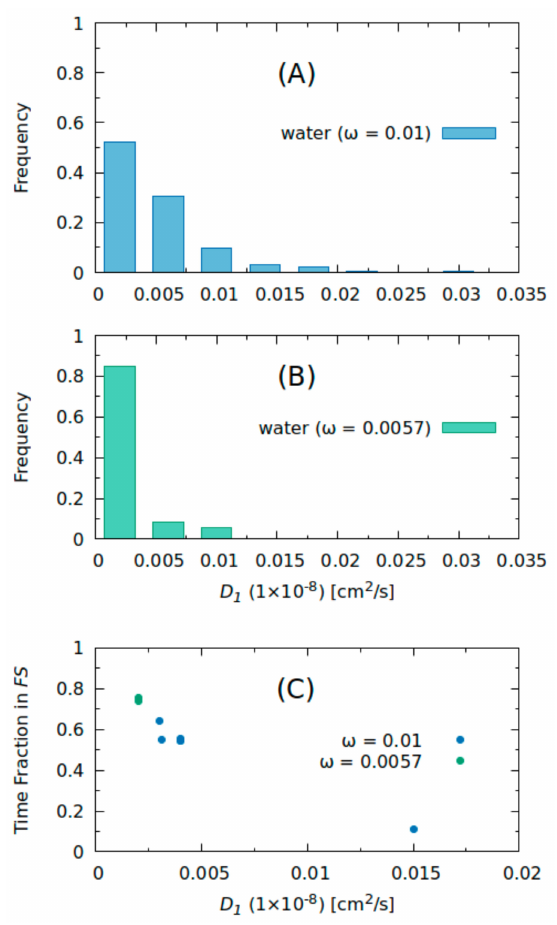
Figure 7. Distribution of self-diffusion coefficients of water molecules for two compositions: ( A ) ω = 0.01 and ( B ) ω = 0.0057. ( C ) Distribution of water self-diffusion coefficients weighted by the time spent by each water molecule forming hydrogen bonds with acceptor AC1 (only first shell) for both compositions ω = 0.01 (blue points) and ω = 0.0057 (green